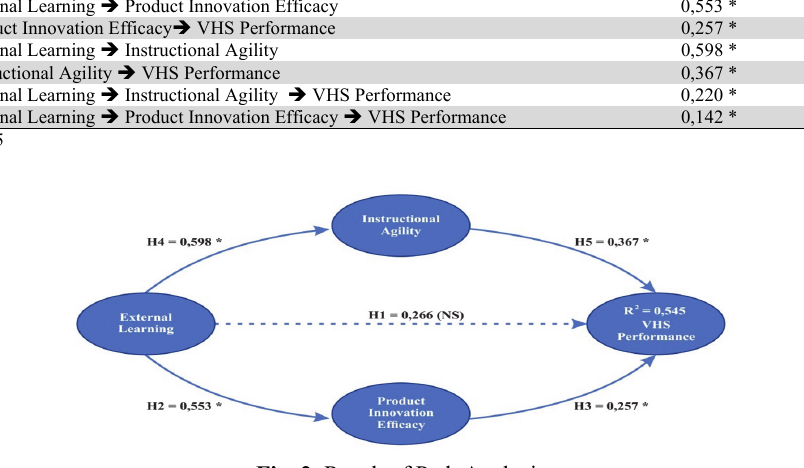
Fig. 2. Result of Path